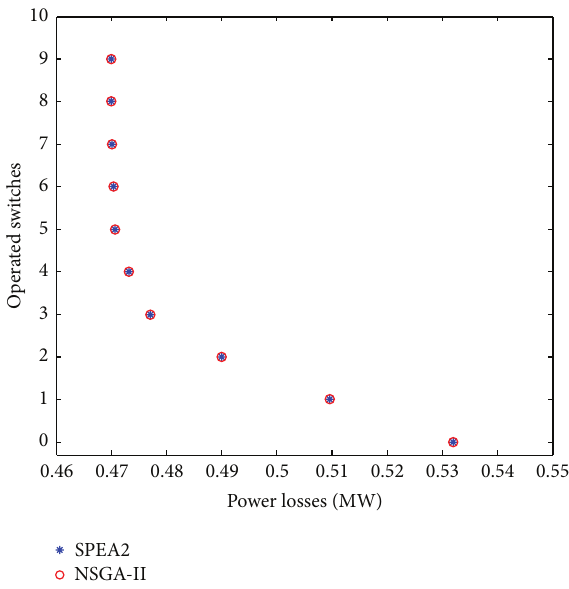
Figure 7: Approximate Pareto-optimal solutions to the problem of optimizing power losses 𝑓 1 and operated switches 𝑓 3 .